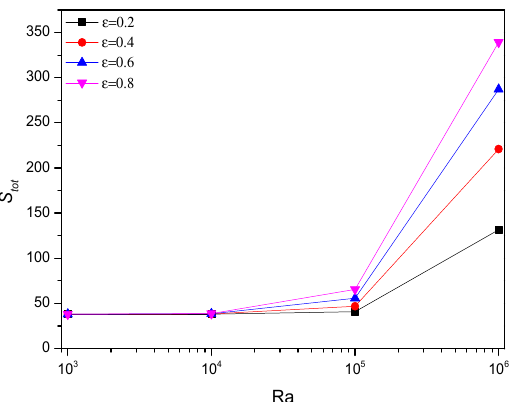
Figure 10. Total entropy as a function of Rayleigh number (Ra) at various values of porosity ( ε p ). Ha = 0, Da = 0.01 and φ = 0.02.